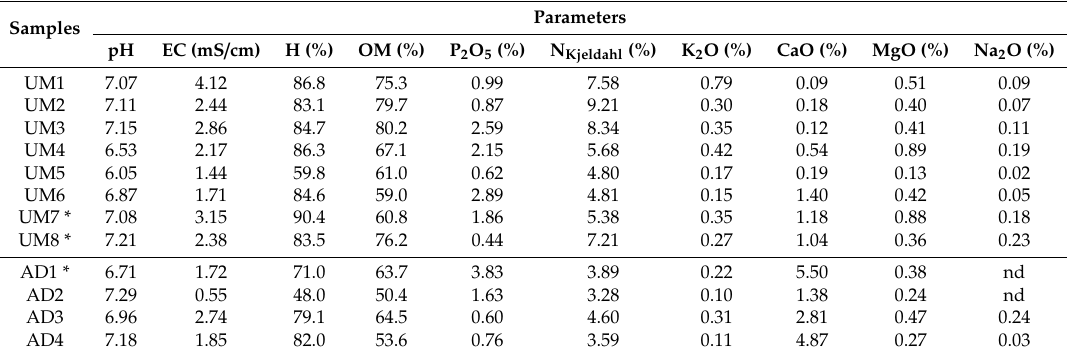
Table 3. Properties of sewage sludge (SS) samples analyzed in this